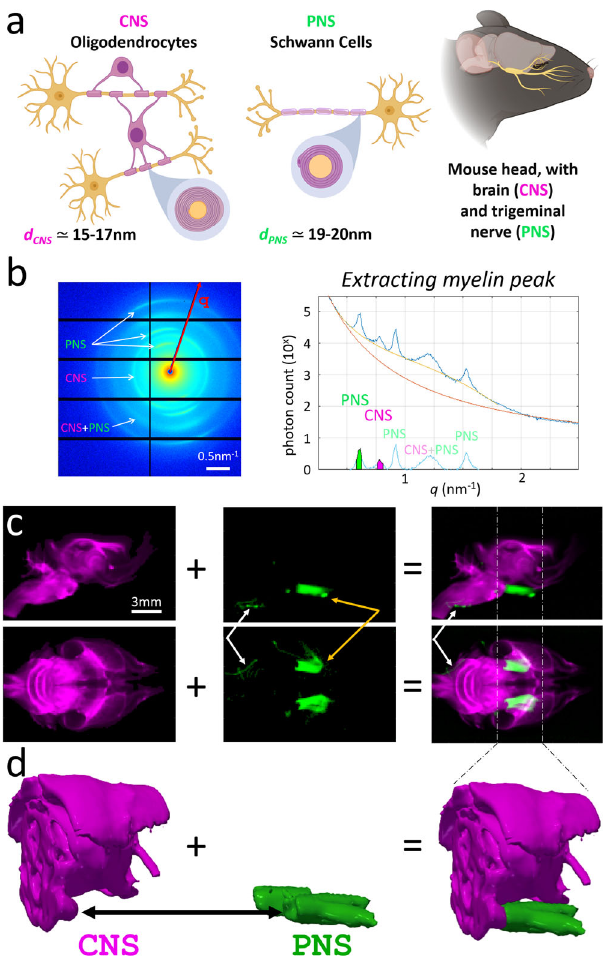
Fig. 6 Central and peripheral nervous system (CNS and PNS) myelin. a Oligodendrocyte- and Schwann cell-produced myelin in CNS and PNS, respectively. Trigeminal nerve shown in yellow in the mouse head scheme. Sketches created with BioRender.com. b Extracting the myelin-speci fi c signal from intensity vs. q plots, from a scattering pattern including both CNS and PNS peaks (arrows). Top curves: blue → raw data, orange → fi rst fi t, yellow → second fi t. Bottom curve: myelin signal. Colored areas: identi fi ed CNS and PNS peaks used for further analysis. c CNS (magenta) and PNS (green) mapping in side- and top-projections, and combined Fig. 7 Control vs. dysmyelinated (shiverer) mouse brain. a Side projection image. Arrows: white → severed brainstem PNS nerves, orange → proximal of mean scattering intensity at myelin peak. b Same projection, with myelin- trigeminal nerves. d CNS and PNS 3D myelin maps, showing the ball-socket speci fi c signal isolated. Color bars: photon-count. c , d 3D myelin maps at CNS-PNS fi t at the trigeminal nucleus. different myelin level (ML) thresholds for the region between dotted lines in a , b . ML units: scattered photons/voxel; ML = 4: highly myelinated areas in control mouse appear, no area in shiverer; ML = 0.1: white matter brain — note the difference in colorbar values. The yielded 3D regions just appear in shiverer vs. almost entire brain for control. e Myelin myelin maps (Fig. 7c, d) enabled quantitative regional assessment levels for control (Ctrl-blue) and shiverer (Shi-orange) brains, for selected of myelin levels (Fig. 7e). For the control brain, highest myelin areas. ROI voxel numbers for control/shiverer: genu: 71/80, body anterior: levels were observed in the internal capsule, with similar myelin 105/94, body posterior: 99/93, splenium: 136/63, internal capsule: 337/ levels for corpus callosum subregions, and much lower yet clearly 119. thalamus: 2740/210, cortex: 1018/403. White matter ROIs were detectable myelination in the cortex. In contrast, myelin levels in eroded with a 3 × 3 × 3 box kernel to avoid partial volume effects. Box plots: the shiverer mouse were very low across all white matter regions, notch → median, box → 25 – 75 percentiles, whiskers → ±2.7 standard typically ~20 – 30 times lower than in control mouse white matter, deviations from mean, red crosses → outliers. Source data are provided as a Source Data fi myelin was barely detectable in the thalamus or cortex. In addi- (cid:1) 18 : 5 nm vs. d (cid:1) 17 nm, quanti fi cation of myelin-speci fi c signals from control and dys- layers than in controls ( d CNS ; shiv CNS ; ctrl myelinated nervous tissue, highlights SAXS-TT ’ s speci fi city for probing myelin levels and structure and reveals its potential for characterizing diseases involving myelin alterations.